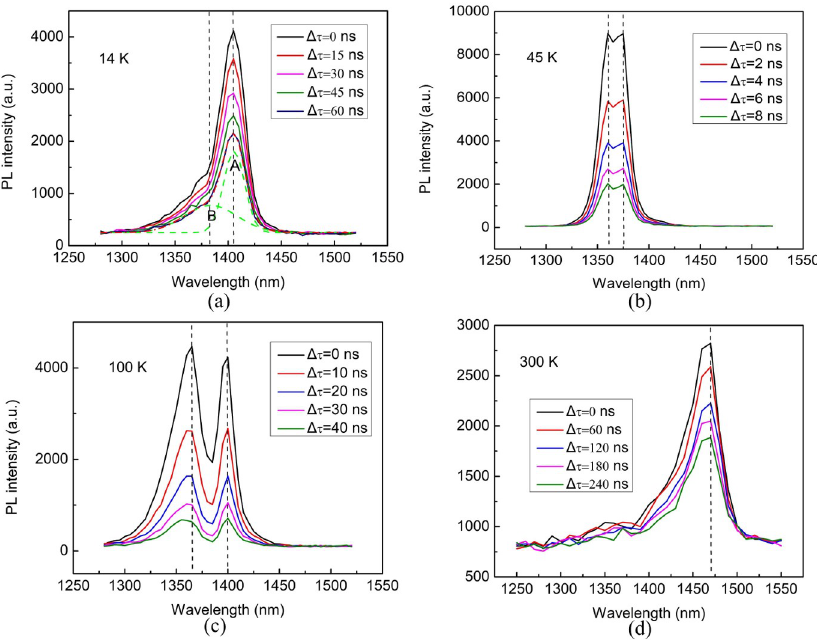
Figure 4. TRPL spectra measured at ( a ) 14 K, ( b ) 45 K, ( c ) 100 K and ( d ) 300 K at various delay